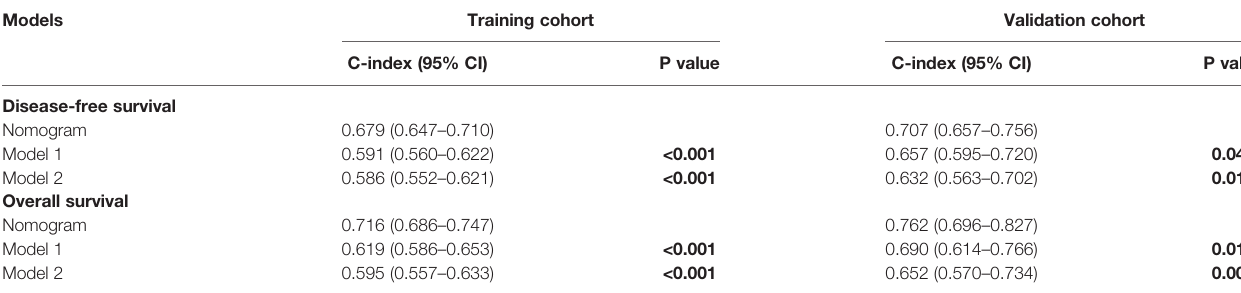
Bold indicates that the P value is statistically signi fi